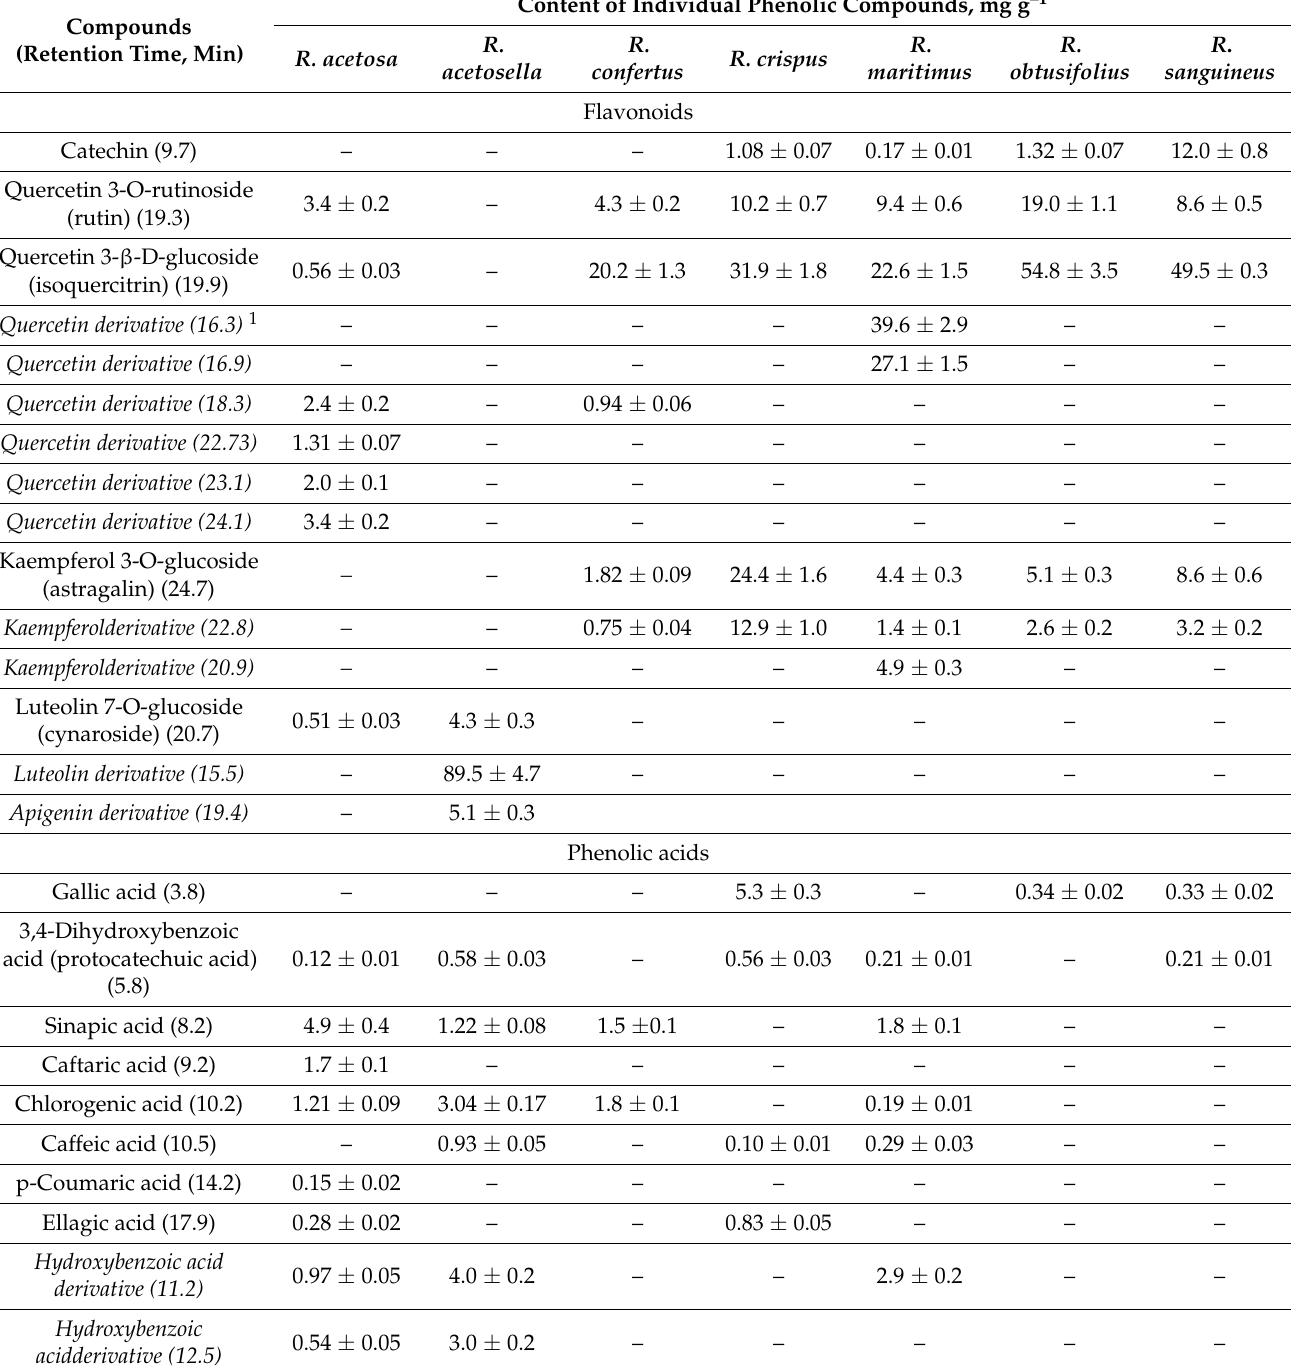
Table 2. Content of phenolic acids and flavonoids in the leaves of different Rumex